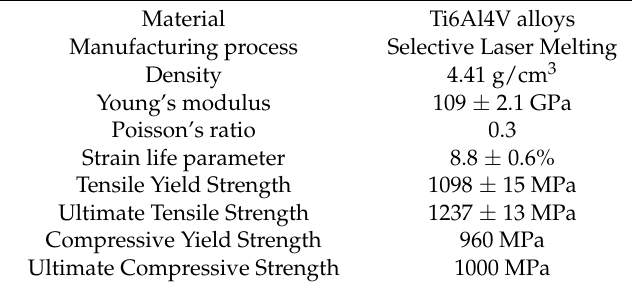
Table 1. Mechanical Properties of Ti6Al4V [15].